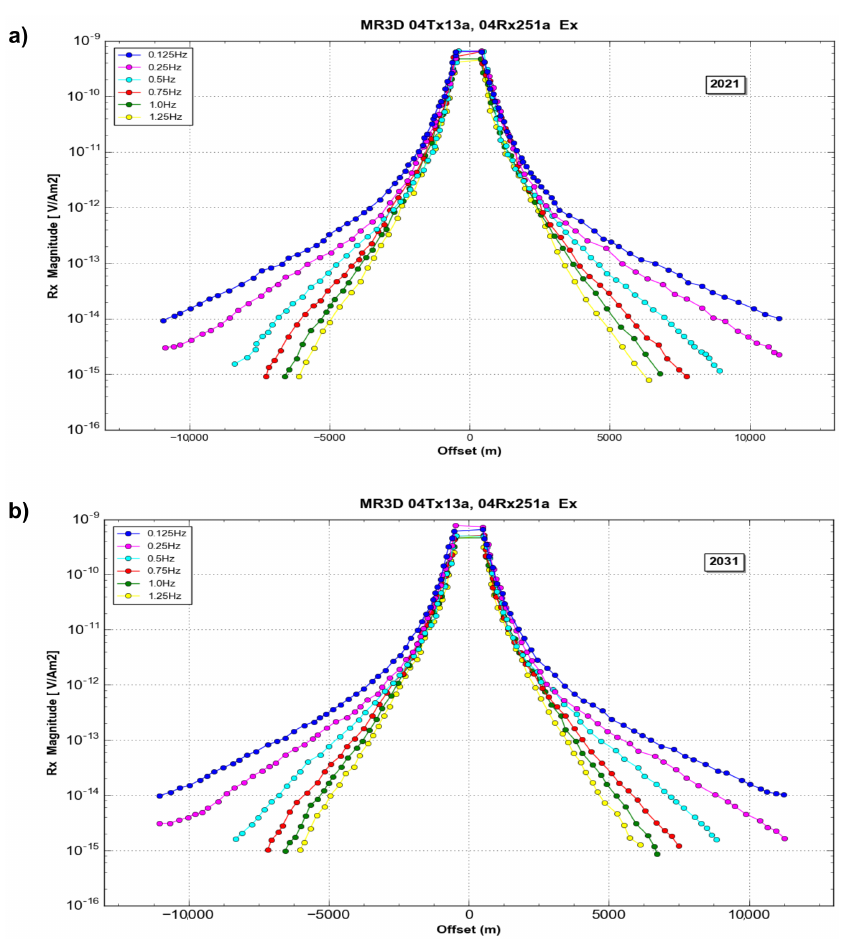
Figure 8. Typical data for the MR3D model showing the overall good quality of the inline electric field. Site 04Rx25a. ( a ) Base survey (2021); ( b ) monitoring survey